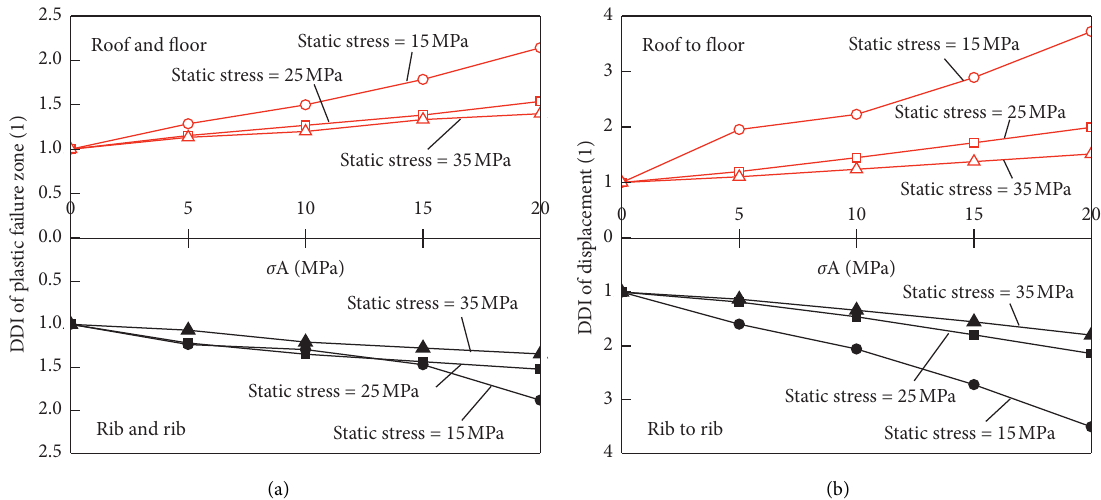
Figure 7: Evolution of DDI for the surrounding rock under different loadings. (a) DDI of plastic failure zone; (b) DDI of displacement.